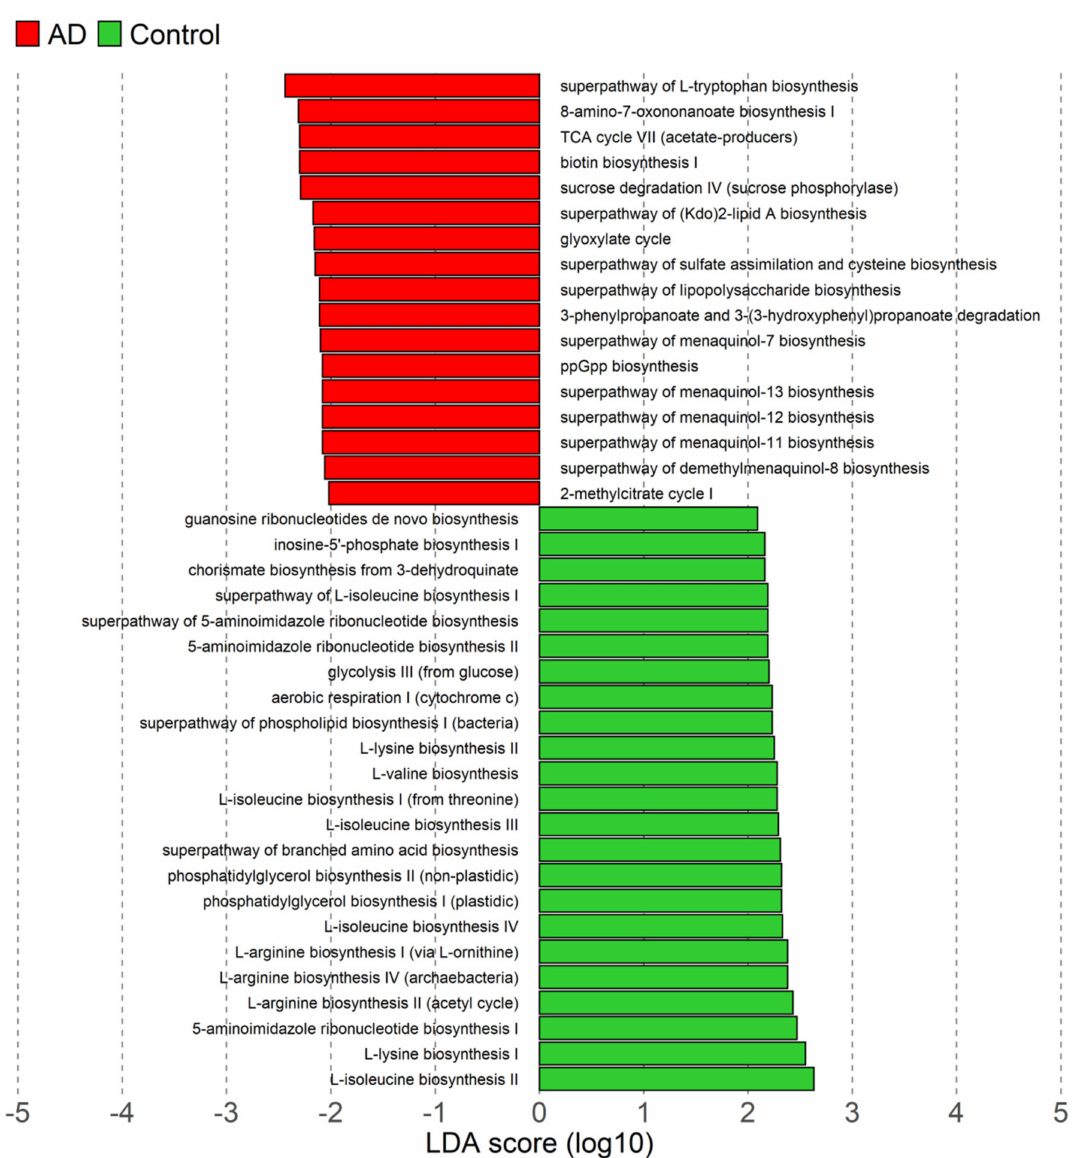
Figure 6. Pathway enrichment analyses and functional categories in AD cases. Pathways and functional categories with LDA score > 2 and p < 0.05 are